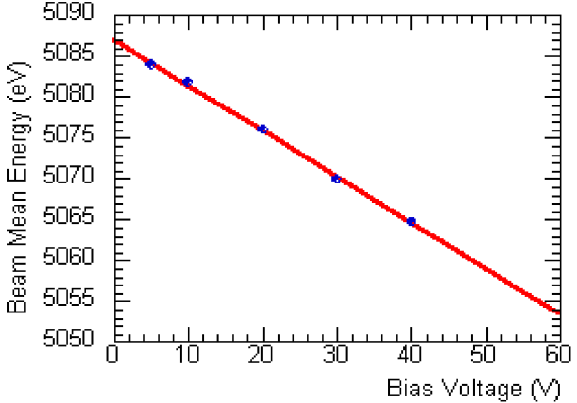
FIG. 15. (Color) Voltage amplitude between the cathode and the grid at the different bias voltages (solid line is fitting line using experimental data shown as dots).